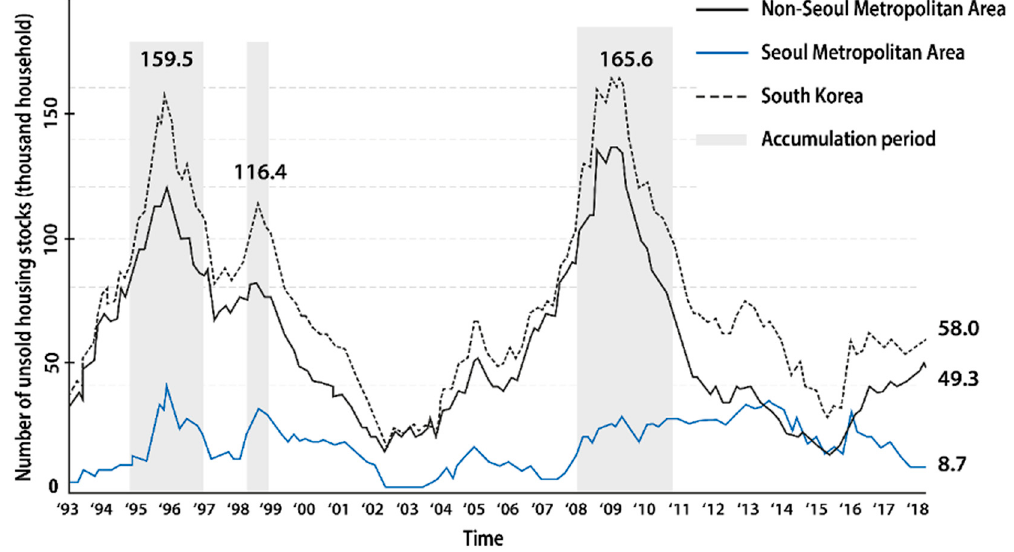
Figure 1. Unsold housing stock in South Korea (1993–2018).